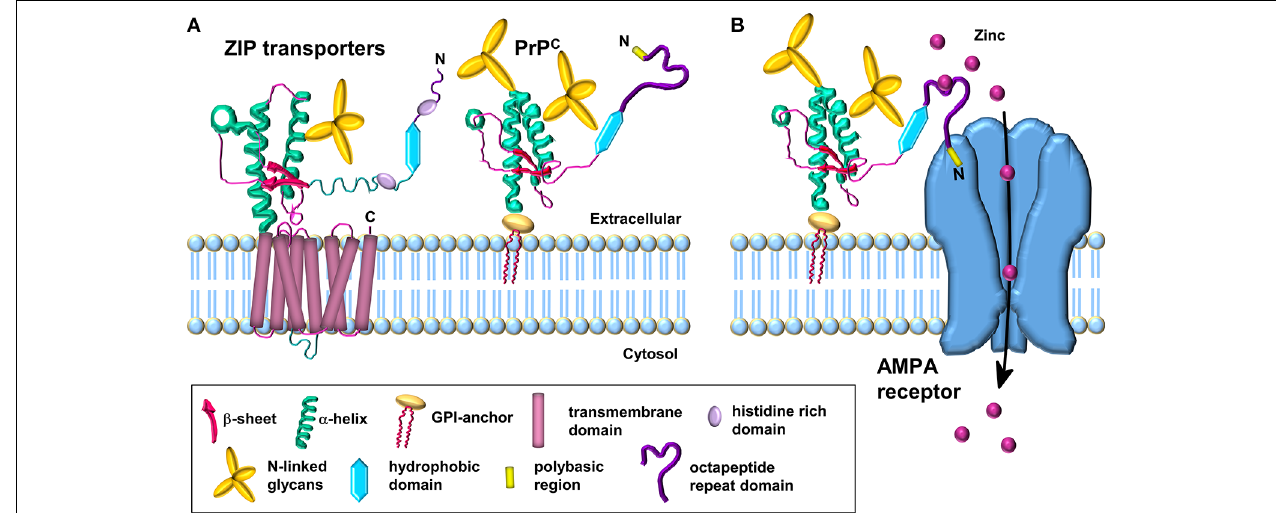
FIGURE 1 | SchematiccomparisonofZIPtransportersandthePrP C -AMPA receptor zinc transporter. (A) Model of the LIV-1 subfamily of ZIPs with a prion-like ectodomain which is coupled to the C-terminal transmembrane domain. PrP C is structurally similar to the ectodomain of the ZIP transporter. (B) PrP C acts as a sensor for zinc in the extracellular space and coordinates